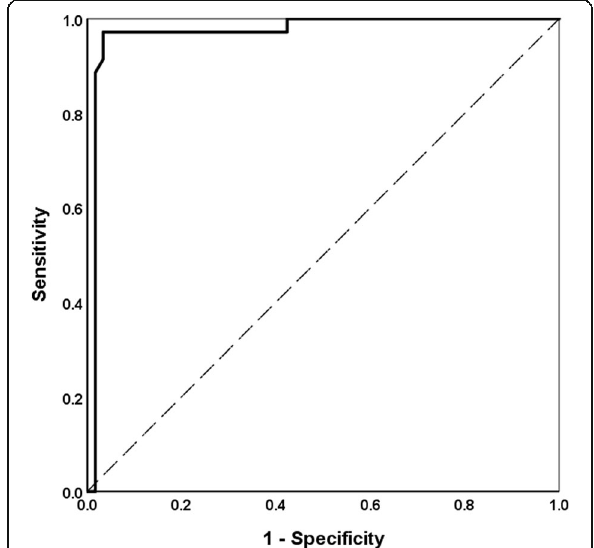
Fig. 3 Sensitivities and specificities of serum markers; ESR, CRP and PCT for discriminating culture-negative SBP from sterile ascites